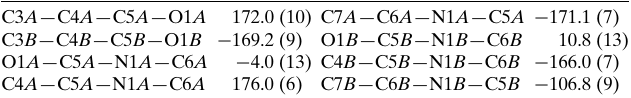
Table 1 Selected torsion angles ( (cid:3) ).